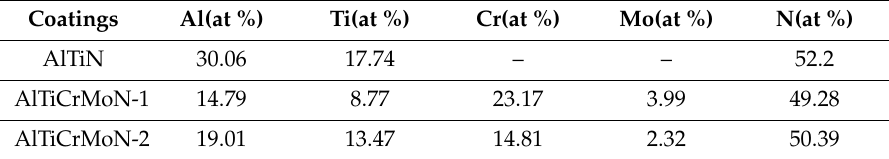
Figure 2. Cross-sectional scanning electron microscope (SEM) micrographs, including secondary electron image (SEI) and scattering electron image (BEI) images, of the deposited AlTiN, AlTiCrMoN-1 and AlTiCrMoN-2 coatings. Table 2. Chemical composition of AlTiN, AlTiCrMoN-1 and AlTiCrMoN-2 coatings.